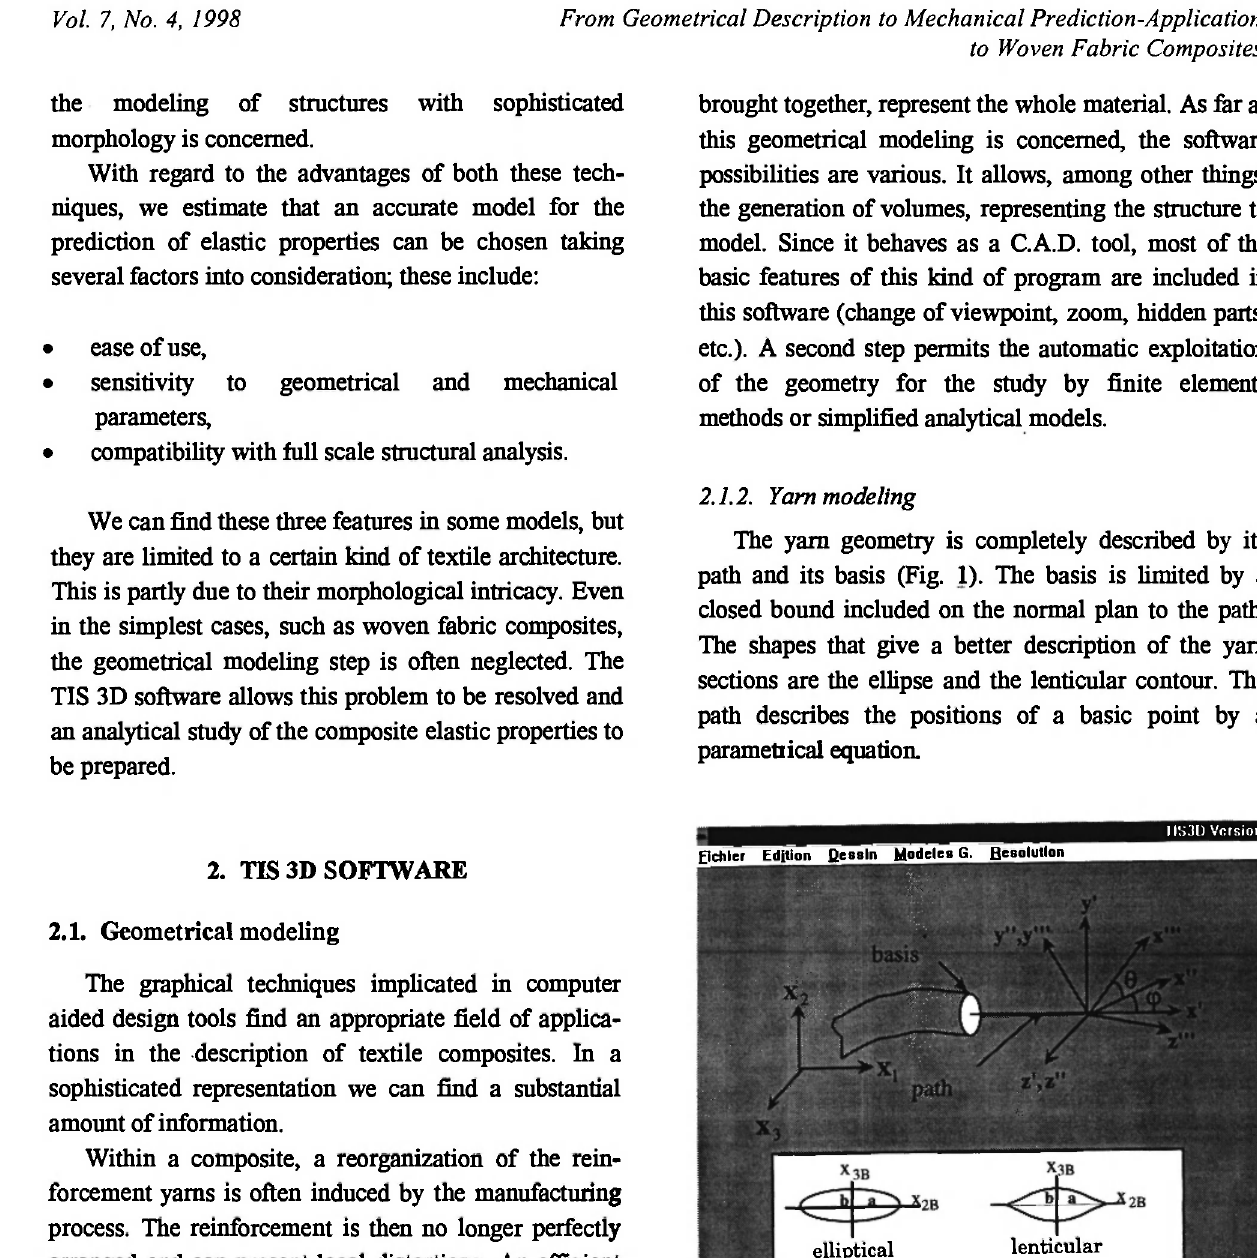
Fig. 1: Basis and path of a yarn ((xj,x (x"',y"',z'") path normal axis, (x',y',z') and (x",y",z") intermediate